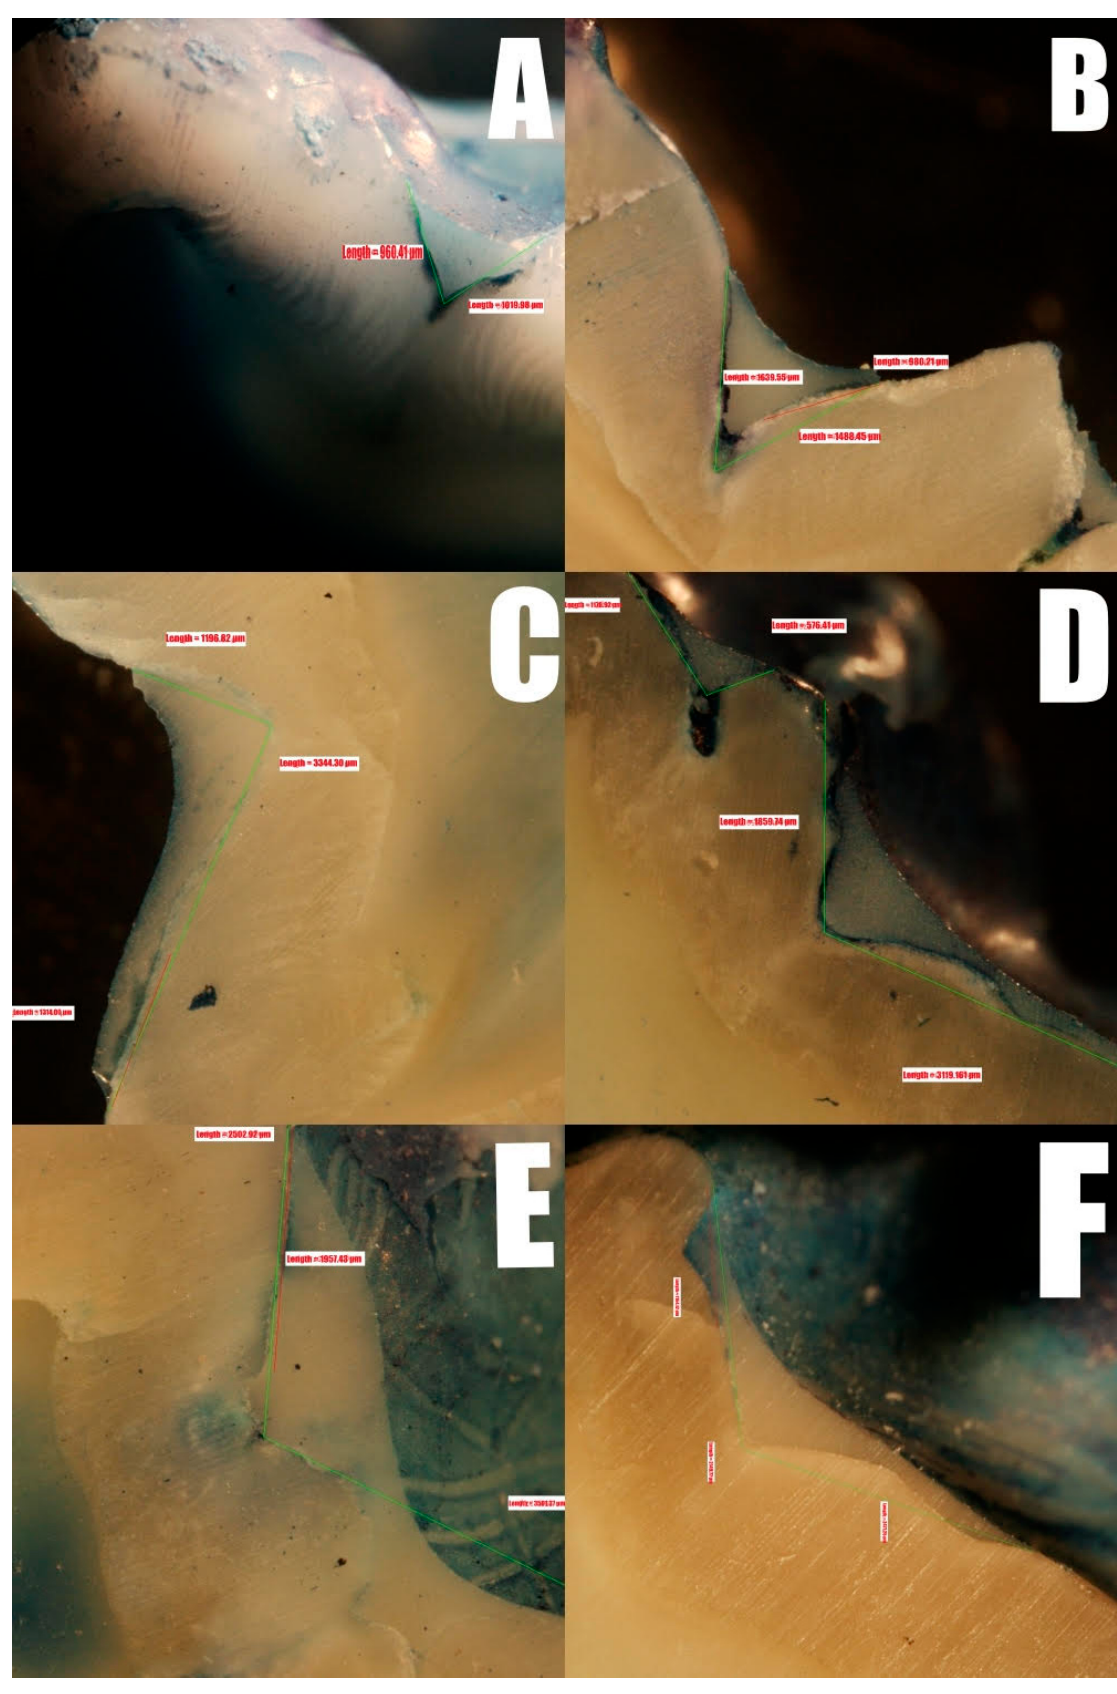
Figure 3. Representative depiction for each tested group.